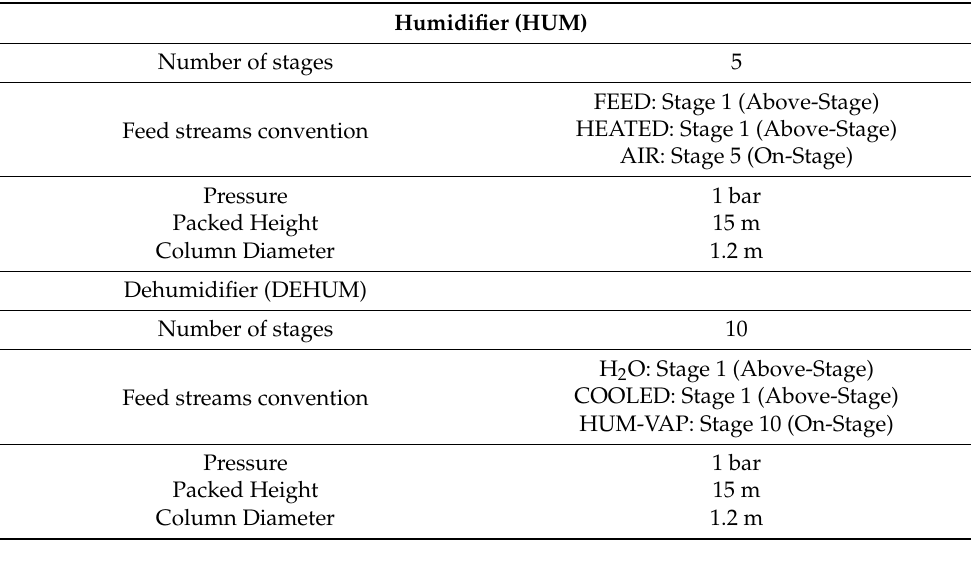
Table 2. Block Characteristics.